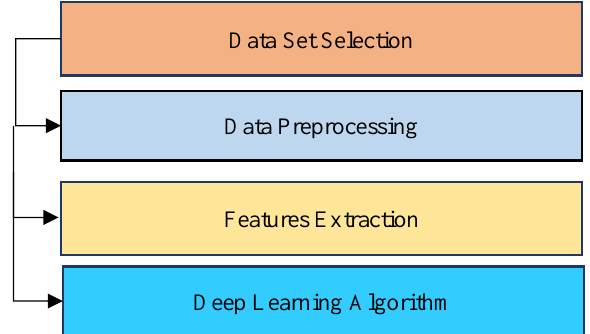
Figure 3. Stages of the proposed method.